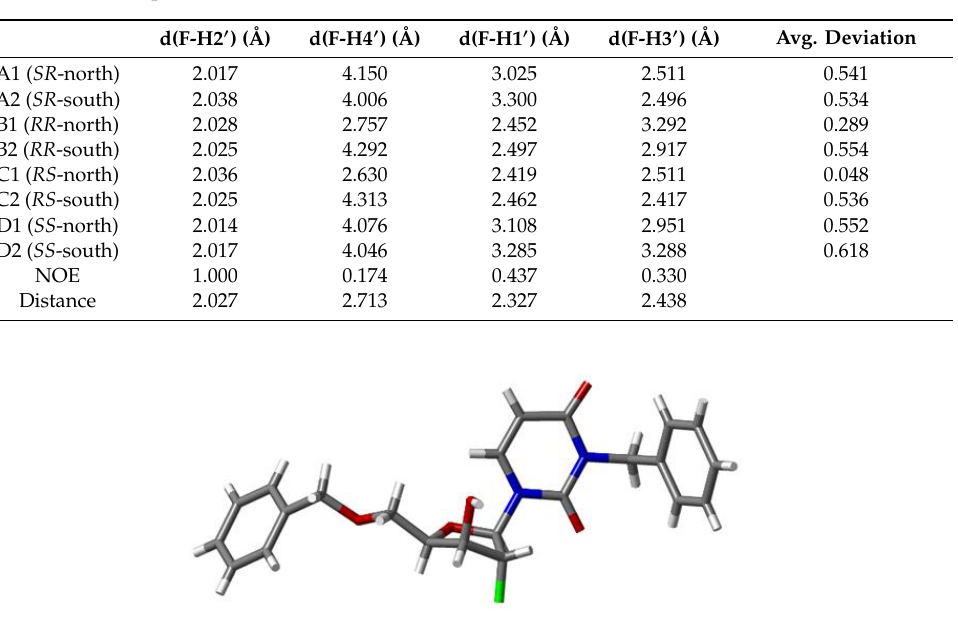
Figure 2. Heteronuclear NOE experiments (HOESY) for compound 13 (282 MHz, CDCl 3 ). The mixing time of the experiment was 600 ms. ( A ) Selective irradiation of the F3′. ( B ) Selective irradiation of the F2′. 2.3. Mechanistic Proposal: Neighbouring-Group Participation As suggested by the NOE and crystallographic data, the stereochemistry for compounds 12 and 13 is suggested to be xylo . For a simpler system, such as an alcohol or diol, an inversion of the stereochemistry at C2′ due to an S N 2 mechanism would be expected. On the contrary, the retention of stereochemistry observed in this case could be contributed to the ‘neighbouring-group participation’, an established phenomenon with sugars and nucleosides. Indeed, the formation of anhydro nucleosides [44] such as 16 and 20 during DAST-type reactions has been previously reported [41,45,46], and an adapted mechanistic proposal is shown in Scheme 3. We propose that the benzyl- as an electron-donating group is postulated to have a significant impact on the mechanistic outcome of the chemical transformation. We suggest that the reaction initially occurs with a nucleophilic attack of the ribose O2′ to the electrophilic sulphur of the Deoxo-Fluor reagent. Then, the lone pair of the oxygen of the uracil moiety attacks the C2′ of the ribose, leading to the first inversion of stereochemistry; the excellent leaving group is removed and the anhydro nucleoside 16 is formed. The fluoride anion attacks the C2′, and this second inversion leads to the fluorinated nucleoside with the retained stereochemistry.